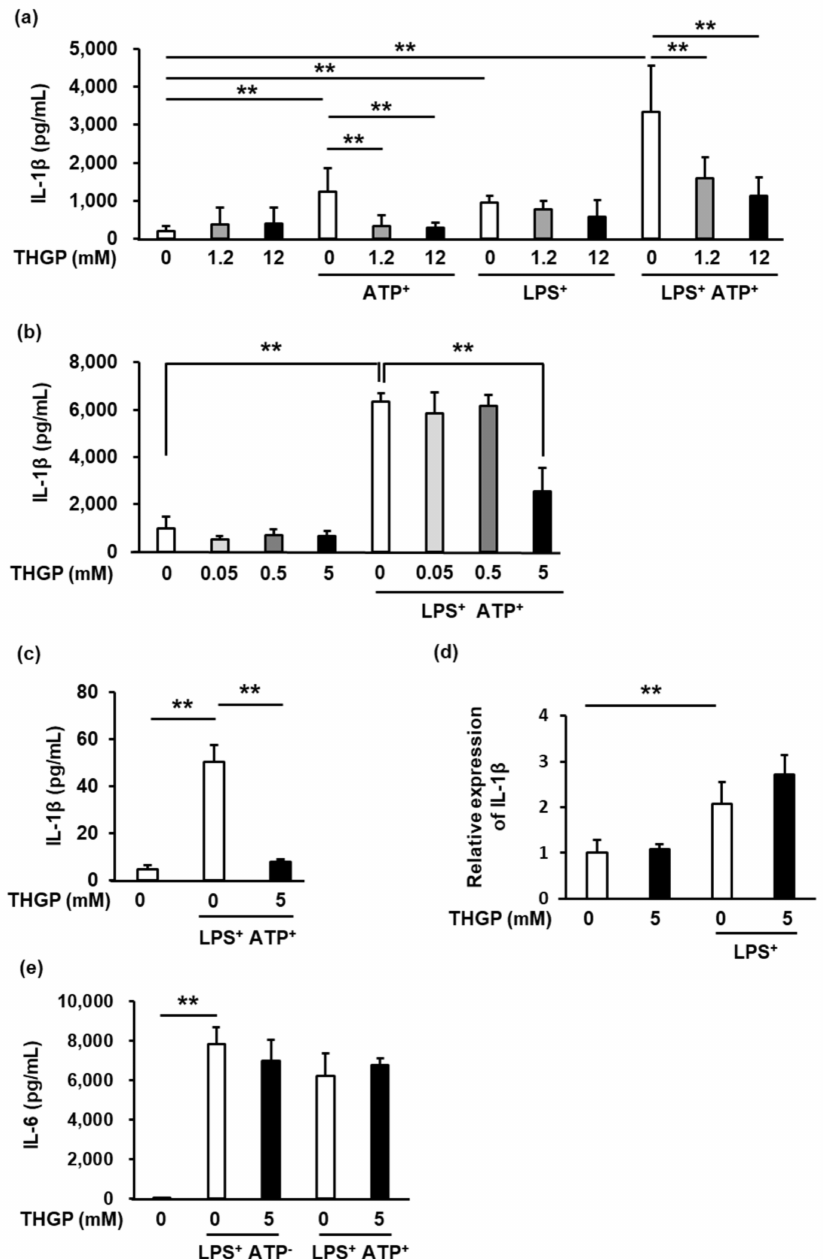
Figure 1. The suppressive effect of THGP on the inflammasome via signaling step 2. ( a ) The secretion of IL-1 β from THP-1 cells was measured by ELISA after stimulation with 10 µ g/mL LPS, 5 mM ATP, or the combination of the two. THGP was added at a concentration of 0–12 mM. ( b ) The secretion of IL-1 β from THP-1 cells was measured by ELISA after stimulation with 10 µ g/mL LPS and 1 mM ATP. THGP was added at a concentration of 0–5 mM. ( c ) The secretion of IL-1 β from RAW 264.7 cells was measured by ELISA after stimulation with 10 µ g/mL LPS and 1 mM ATP. THGP was added at a concentration of 5 mM. ( d ) The effect of THGP on the mRNA expression of IL-1 β in THP-1 cells treated with 10 µ g/mL LPS and 5 mM THGP was investigated by real-time RT–PCR. ( e ) The secretion of IL-6 from THP-1 cells was measured by ELISA after stimulation with 10 µ g/ µ L LPS and/or 5 mM ATP. THGP was added at a concentration of 5 mM. The mean and S.D. are shown. n = 6. ** p <